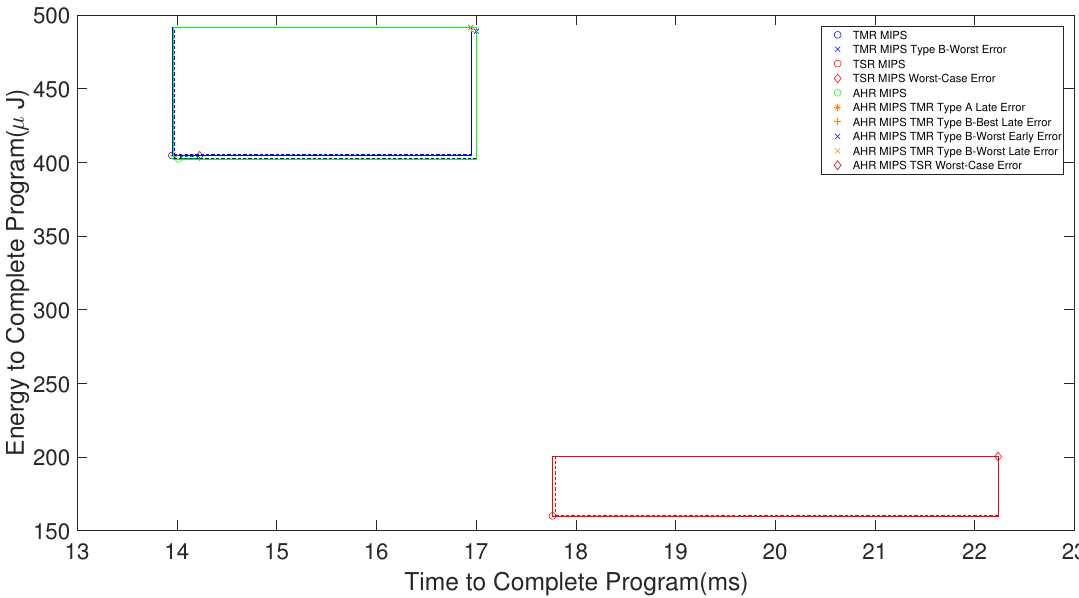
Figure 14. Average performance bounds for AHR MIPS with a TMR to TSR point at 70,000